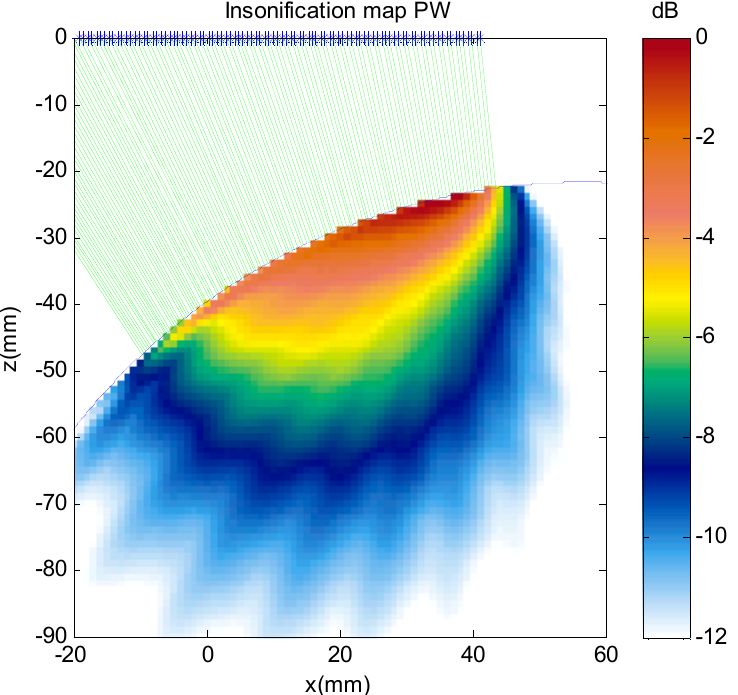
Figure 3. Simulated insonification map for the aluminum cylindrical part for 15 plane waves from − 70° to 70° in 10° steps.